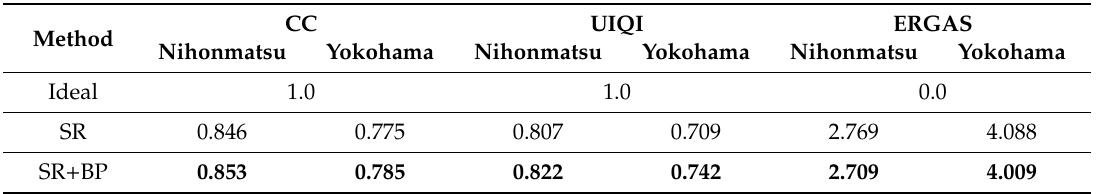
Table 4. Numerical evaluation of image intensities with or without the back-projection process of the Table 5. Numerical evaluation of image intensities obtained by SCMP, SR, and the tradeoff process. intensity obtained via sparse representation. The best values are given in The best values are given in bold.